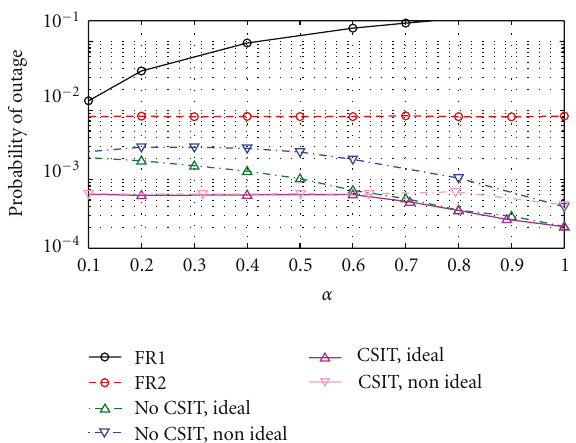
Figure 9: Joint probability of outage for a target spectral e ffi ciency R = 2bps/Hz, as a function of α , 0 . 1 ≤ α ≤ 1, for two isolated base stations and SNR = 15dB.